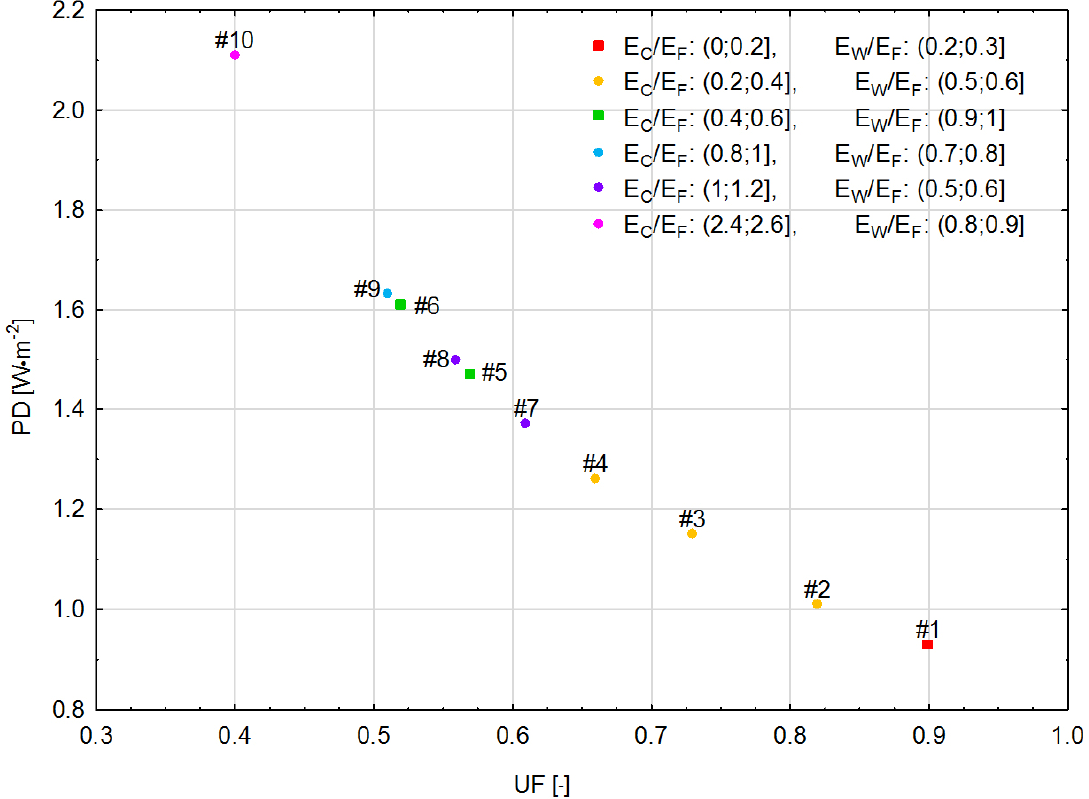
Figure 14. Relationship between power density (PD) and utilization factor (UF), categorized by E C /E F and E W /E F , for the analyzed lighting cases in the corridor.